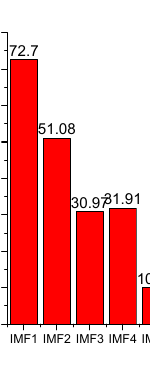
Figure 12. Rail surface fault.